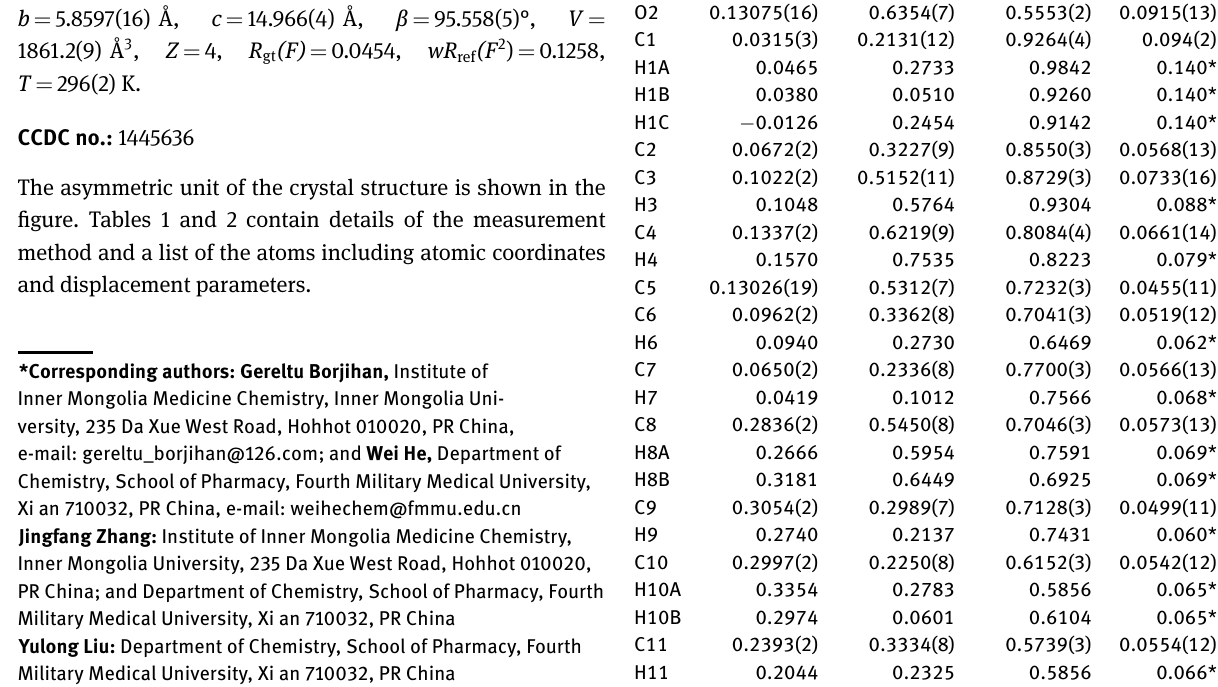
The asymmetric unit of the crystal structure is shown in the figure. Tables 1 and 2 contain details of the measurement method and a list of the atoms including atomic coordinates and displacement parameters.